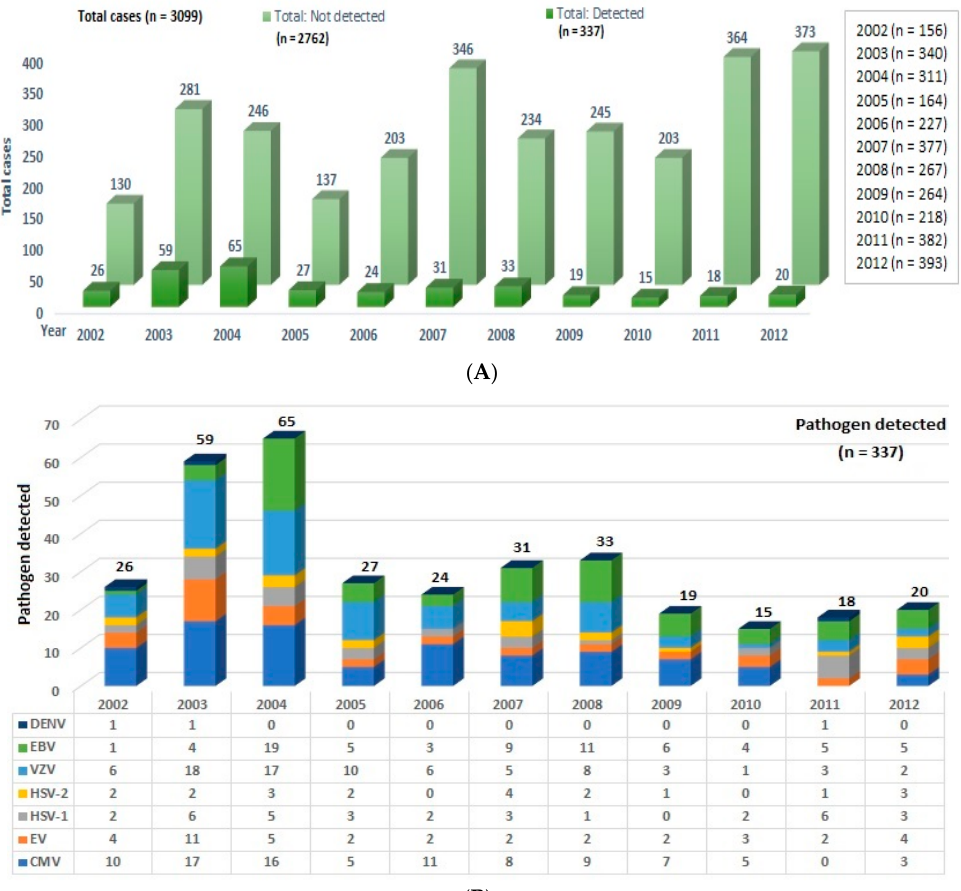
Figure 3. Demographic of individuals with confirmed enterovirus encephalitis in 2002–2012, and in 2013–2018.